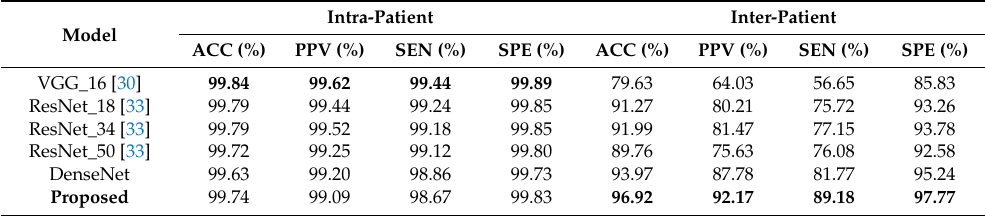
Table 14. Comparison of di ff erent deep networks for classification of Normal, MI, CAD, and CHF. Model